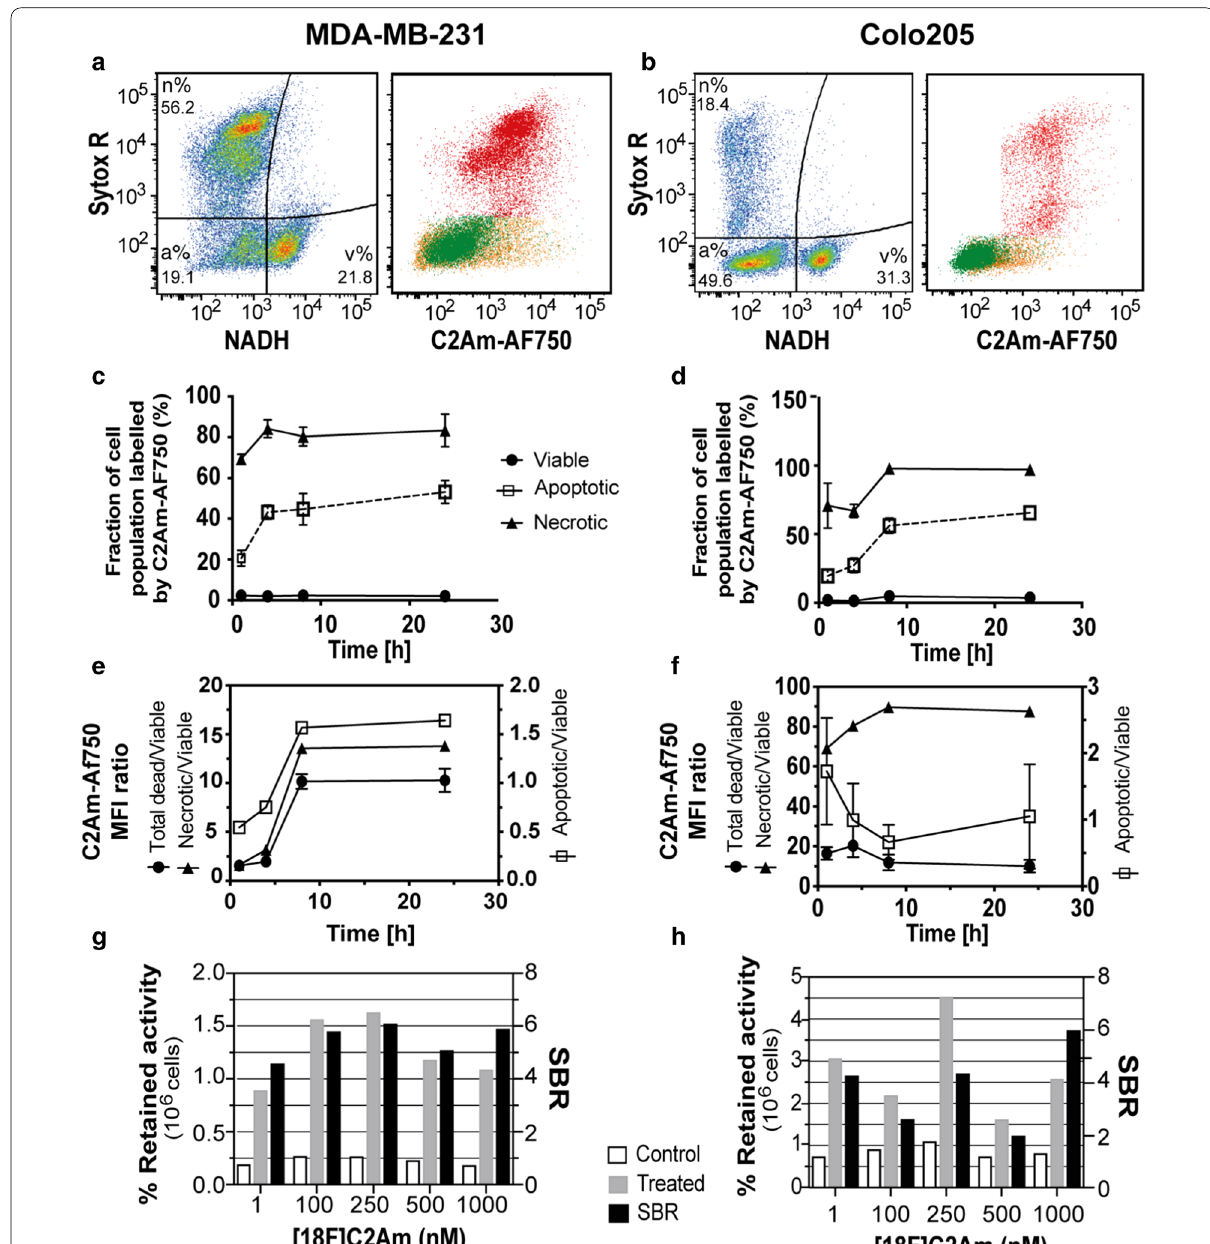
Fig. 2 C2Am binds to dead cells in vitro. Flow cytometric analysis of MEDI3039‑treated MDA‑MB‑231 ( a ) and Colo205 ( b ) cells shows three distinct populations (first and third plots, from left), which were gated based on their levels of UV A autofluorescence (NADH content) and plasma membrane integrity (Sytox R) as: viable (v%), apoptotic (a%) and necrotic (n%) cells. C2Am‑AF750, a near infrared fluorophore‑labeled derivative of C2Am labels (second and fourth plots) preferentially bound apoptotic (orange) and necrotic (red) cells, in comparison with viable (green) cells ( c , d ). Plots of C2Am‑AF750 mean fluorescence intensity (MFI) ratios for necrotic/viable, apoptotic/viable and dead/viable MDA‑MB‑231 ( e ) and Colo205 ( f ) cells following treatment with MEDI3039 (mean SD, n 3), error bars lie within the symbols when not shown. MEDI3039‑treated MDA‑MB‑231 ± = ( g ) and Colo205 ( h ) cells were incubated with 18 F‑C2Am at different concentrations (1–1000 nM) and the fraction of activity retained in the cell pellets (%) after three washes was measured. The signal‑to‑background ratio (SBR, black bars) of treated (grey bars) versus vehicle‑treated (open bars, control) cells is also